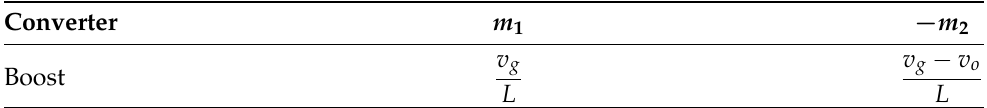
Table 1. Slope of the inductor current